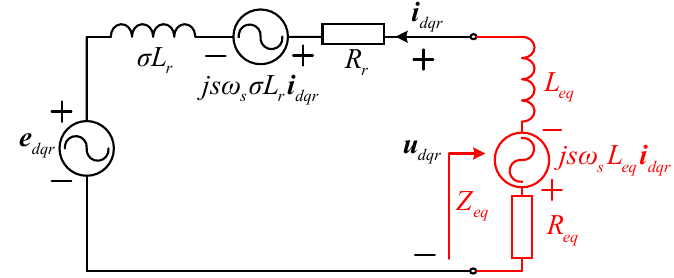
Figure 4. The topology of DFIG-based WECS. connected in parallel, and the same control strategy is adopted to make them equivalent to inductive impedance to suppress the faulty rotor current jointly. At this point, it is assumed that the currents flowing through the two converters are equal. Then the equivalent circuit viewed from the rotor side can be shown in Figure 5, where Z eq is the parallel equivalent impedance of the RSC and GSC. This is the basic principle of the proposed DISC strategy. Next, some specific control objectives, such as voltage constraints, current constraints, accelerated flux linkage attenuation, and torque ripple reduction, are analyzed and discussed to select substitution impedance values.